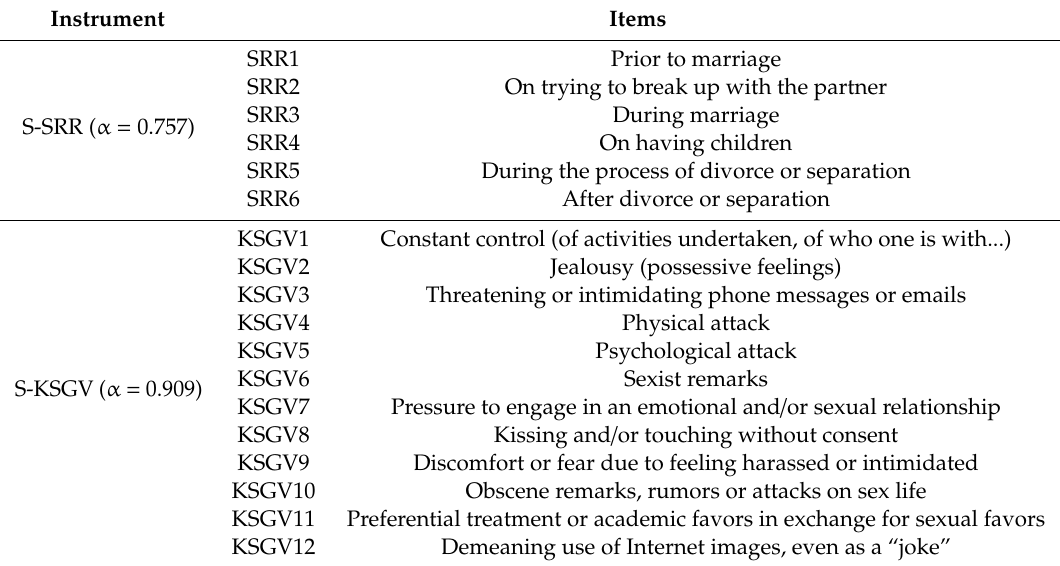
Table 1. Reliability and items for the instrument “Situations of Risk in a Relationship” (S-SRR) and “Knowledge of Situations of Gender-based Violence”